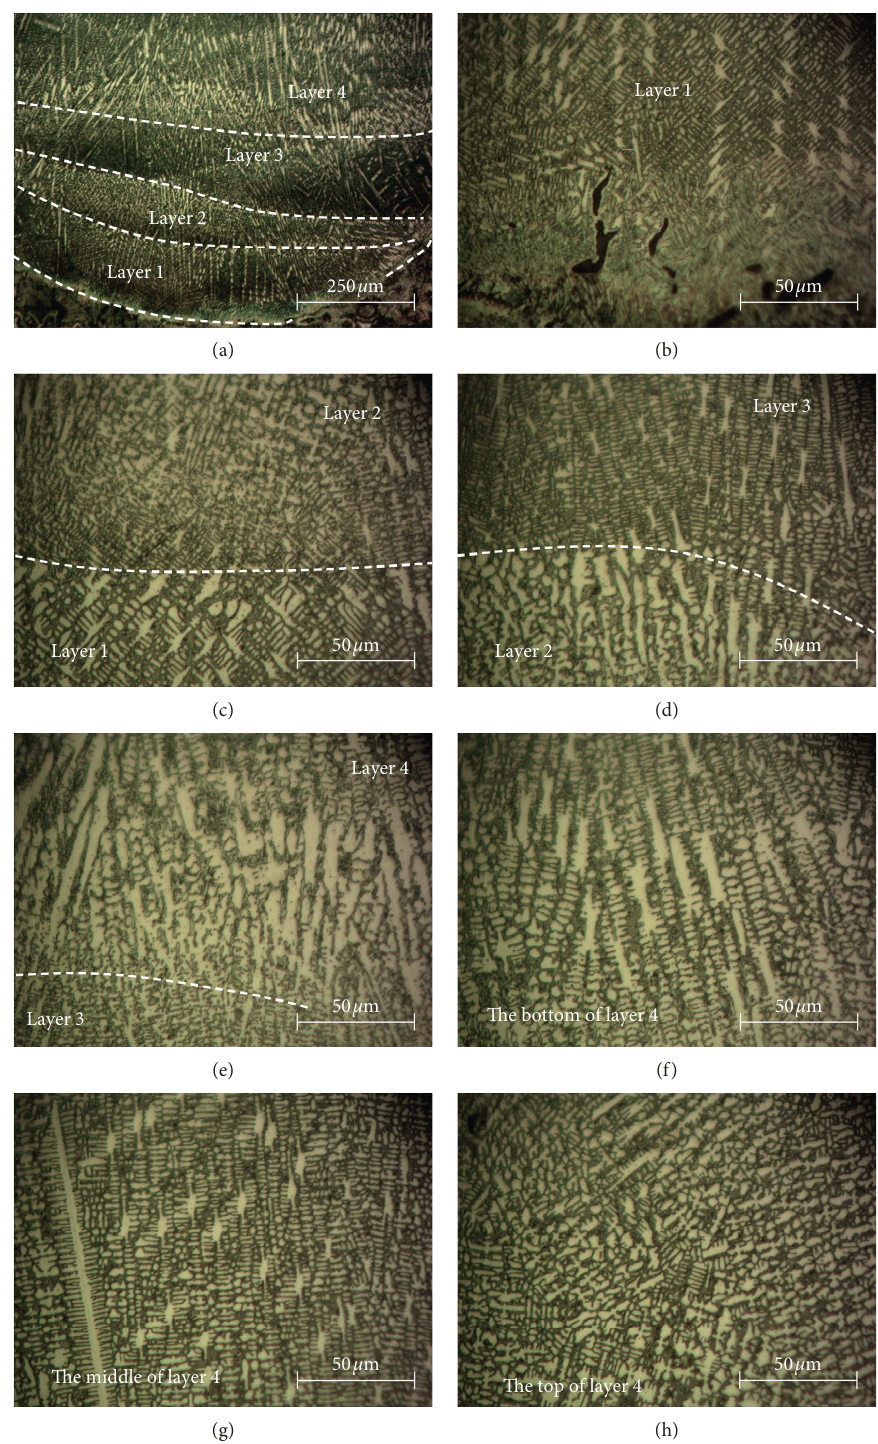
Figure 11: Microstructure of NiCoCrAlY coating at different